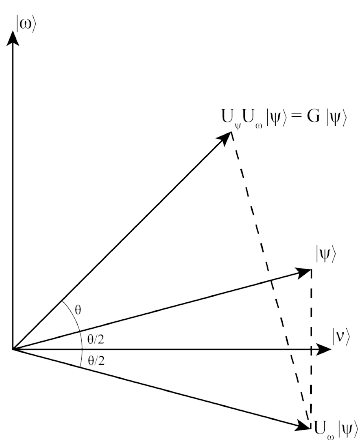
Figure 4. Geometric interpretation of Grover’s